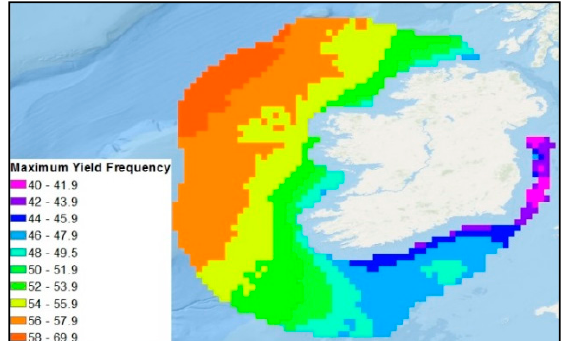
Figure 9. Maximum energy yield frequency at 80 m a.s.l. of Ireland’s waters between 20 km and 200 km from the coast, derived from ASCAT-A and -B observations for the years 2013 to 2016 and ASCAT-A 2012.